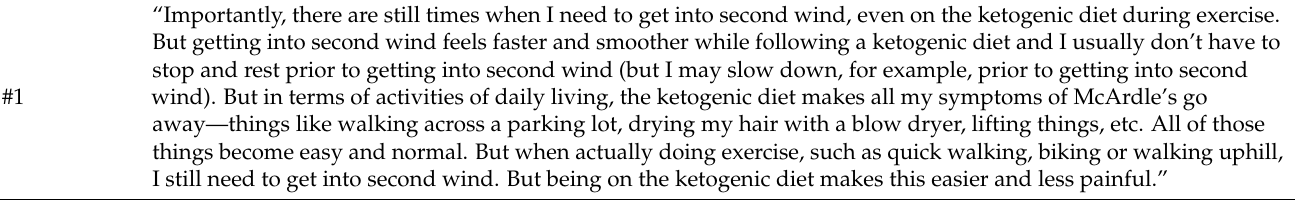
Table 2. Quotes from selected